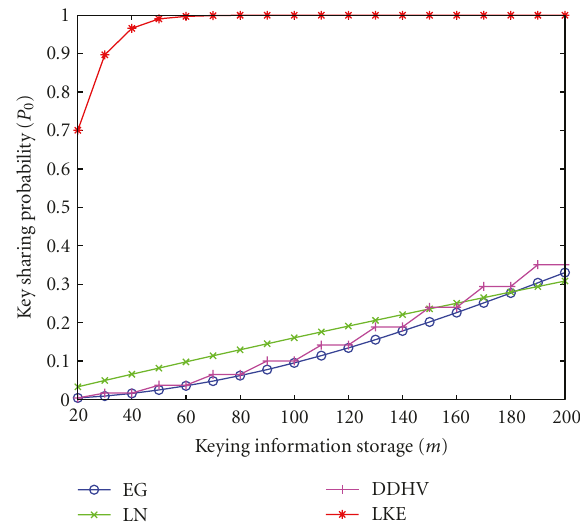
Figure 7: Test 4. Comparison of In-Situ schemes and Probabilistic- based Key Predistribution Schemes: Key Sharing Probability vs. Keying Information